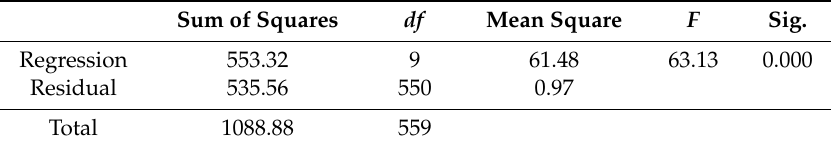
Table 9. ANOVA table for the developed MLR